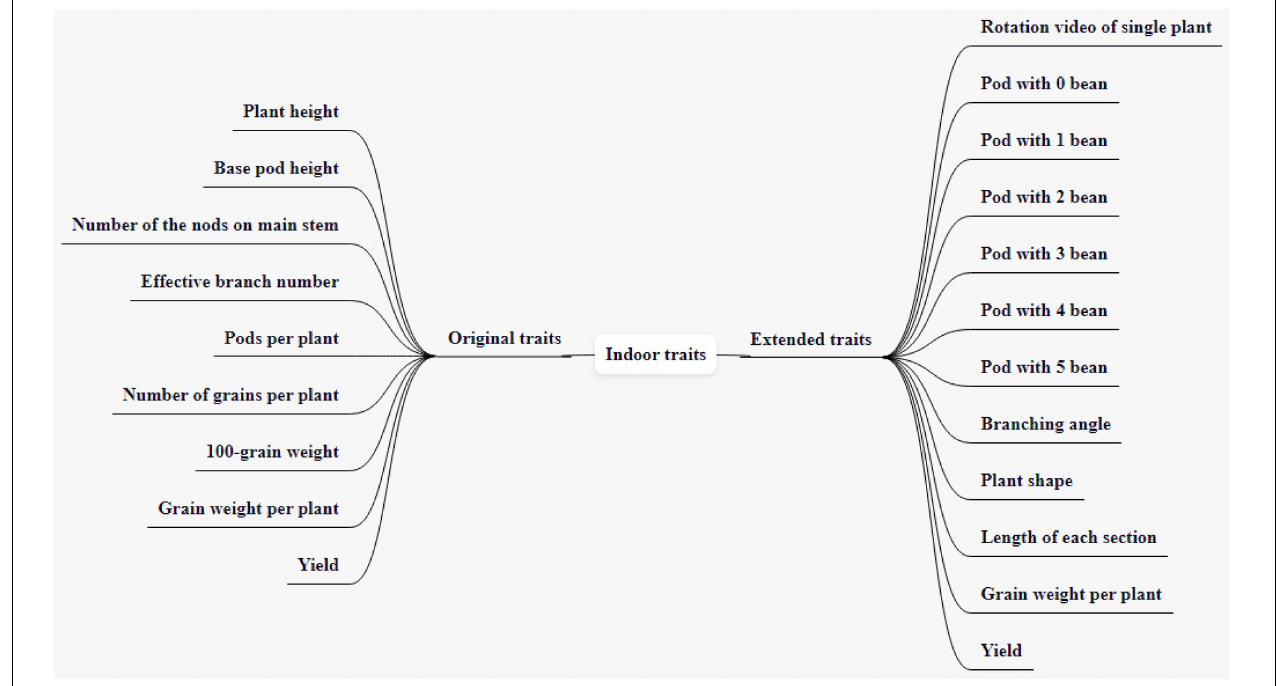
FIGURE 3 | Indoor traits and the